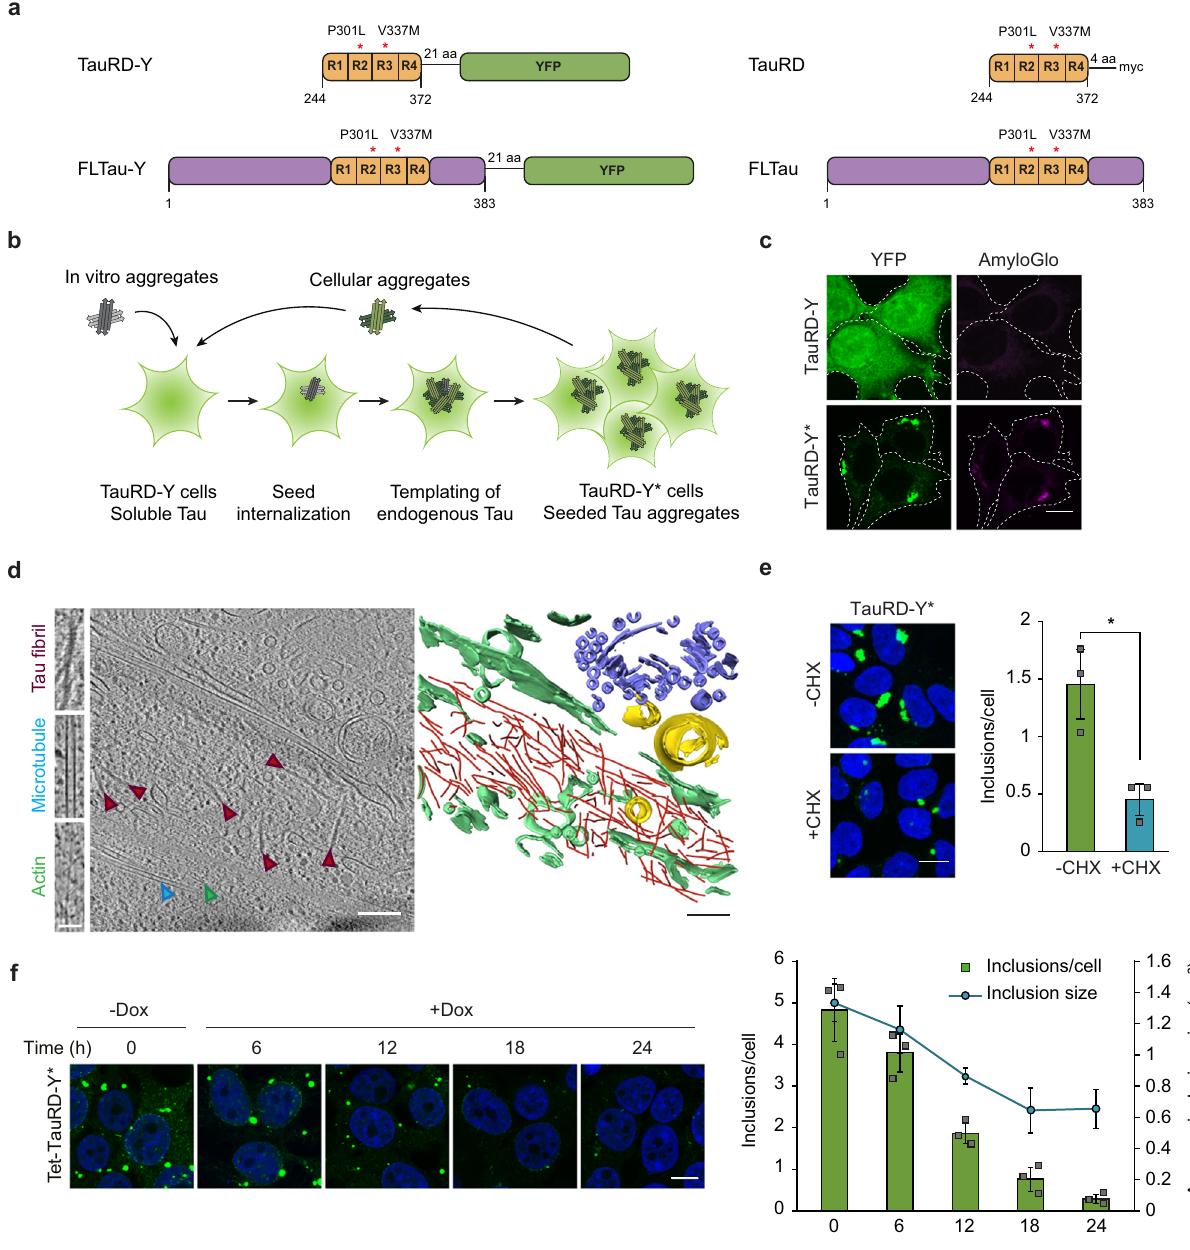
Fig. 1 | TauRD-Y forms amyloid-like aggregates that are cleared from cells. a Schematic representation of Tau constructs used in this study. TauRD-Y, the repeat domain, and FLTau-Y, the 0N4R isoform of full-length (FL) Tau with two frontotemporaldementia-associatedmutations,P301LandV337M,fusedtoYFPvia 21amino acid (aa)linkersorwithoutYFP. b Schematicrepresentationofaggregate seeding.Extracellularadditionofpreformed Tauaggregatesinducestemplatingof intracellularTauintoaggregatesthatpropagatewithcelldivision.Aggregateseeds may be generated in vitro or contained in cell lysate. TauRD-Y, naïve cells con- tainingsolubleTauRD-Y;TauRD-Y*,cellscontainingTauRD-Yaggregates. c Staining ofTauRD-YandTauRD-Y*cellswiththeamyloid-speci fi cdyeAmylo-Glo(magenta). Whitedashedlinesindicatecellboundaries.Scalebar,10 µ m. d TauRD-Yaggregates are fi brillarinstructure.Left, a1.7nm thicktomographicsliceof a TauRDinclusion